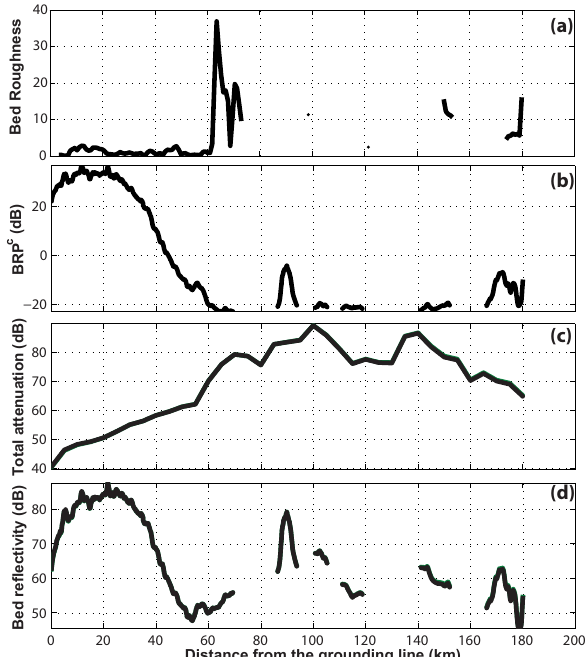
Fig. 4. Subglacial conditions along the central flowline. (a) Bed roughness index RI; (b) geometrically corrected bed-returned power BRP c ; (c) englacial attenuation L ; (d) bed reflectivity R .